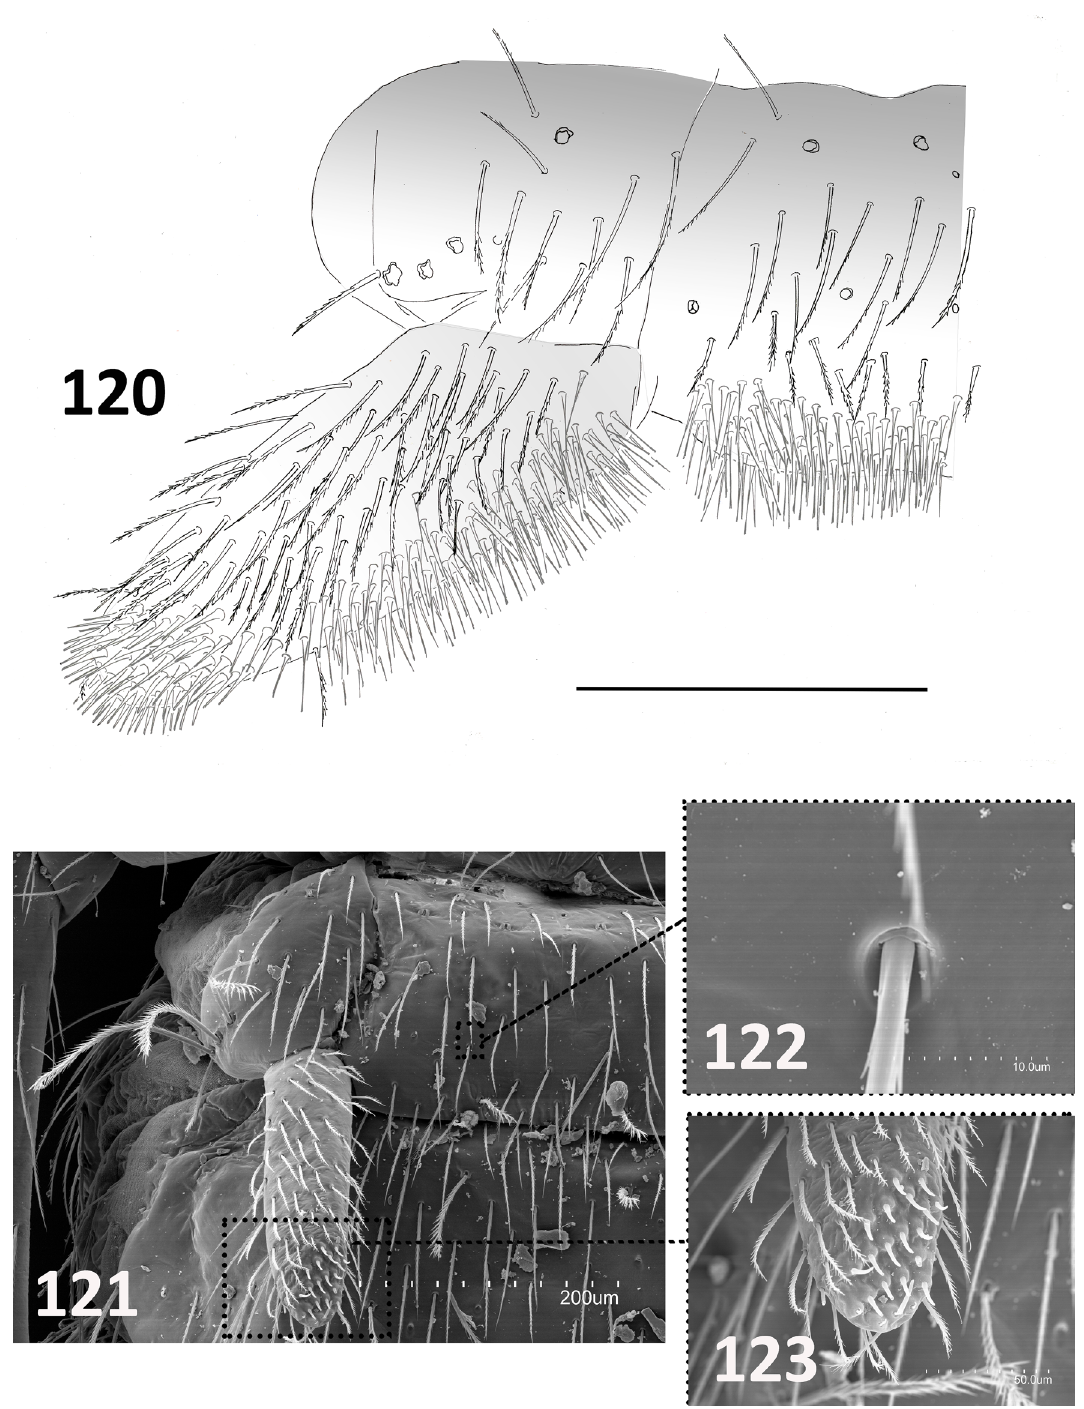
Figs 120–123. Plusiocampa ( Plusiocampa ) pouadensis pouadensis (Denis, 1930), from Grotte Pouade, Banyuls-sur-Mer, France (Coll. AS). 120 . ♂, urosternite I, right side, with glandular g 121 . ♀, urosternite I. 122 . Surface of urosternite I, detail. 123 . ♀, urosternite I appendage. Scale bar: 120 = 0.2